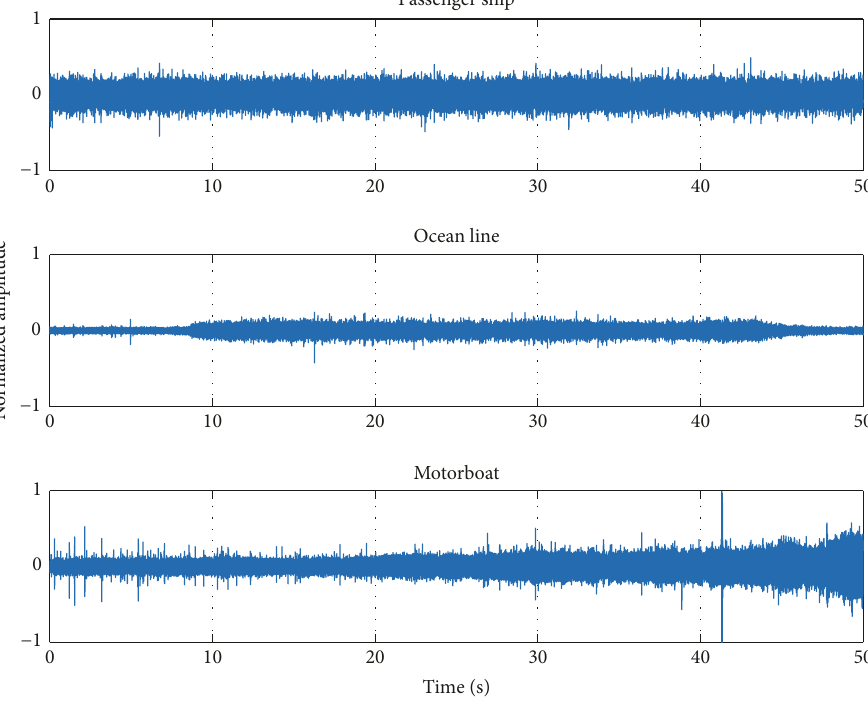
Figure 8: Recorded time series of three types of ship-radiated noise.